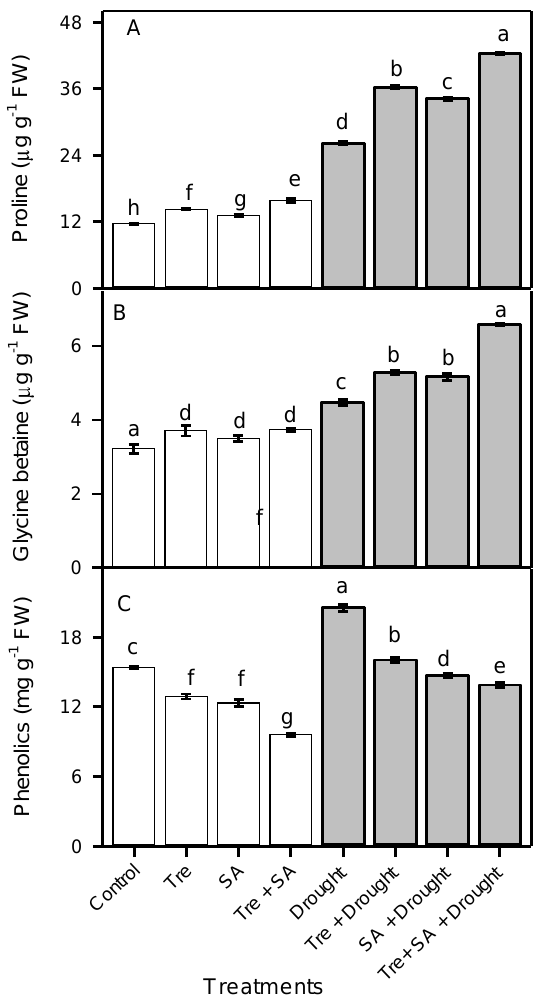
Figure 2. Leaf concentrations of proline ( A ), glycine betaine ( B ), and total phenolics ( C ) in sweet basil ( Ocimum basilicum ) after foliar application of 30 mM trehalose (Tre) and/or 1 mM salicylic acid (SA) during drought stress. One month old seedlings were watered to 100% (control) or 60% (drought) field capacity for 20 days. Tre and/or SA were then applied twice with a 5 day interval. The watering conditions were maintained for an additional 2 weeks until plants were harvested. Data are the means ± SE ( n = 6). Different letters above the bars indicate significant differences according to Duncan’s multiple-range test at the p < 0.01 level.